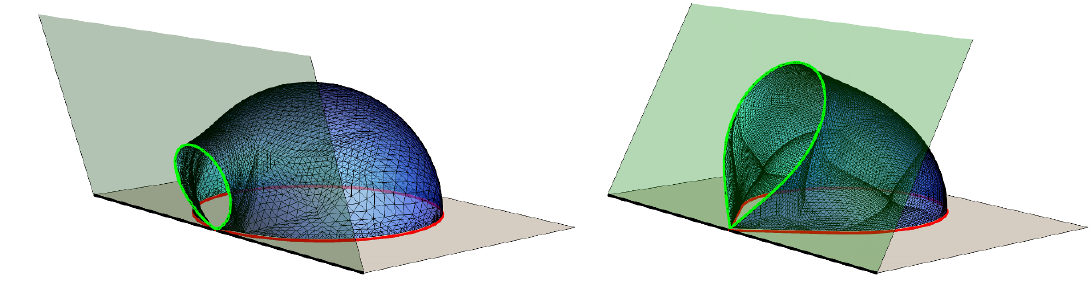
Figure 16 . Minimal surfaces ^ (cid:13) A obtained with Surface Evolver and anchored to a single drop A (whose boundary is the red solid curve in the z = 0 grey half plane) which has only the tip on the boundary. Here A has been chosen in a symmetric way (i.e. ~ (cid:13) = (cid:13) ). In the left panel (cid:11) = (cid:25)= 2 : 5, ! = 2 : 6 and L = 0 : 5, while in the right panel (cid:11) = 2 (cid:25)= 3, ! = (cid:25)= 2 and L = 1 : 5. In both panels " = 0 : 03. This kind of minimal surfaces have been constructed to (cid:12)nd the data corresponding to ! > ! c in (cid:12)gure 17, which have been labeled by empty black